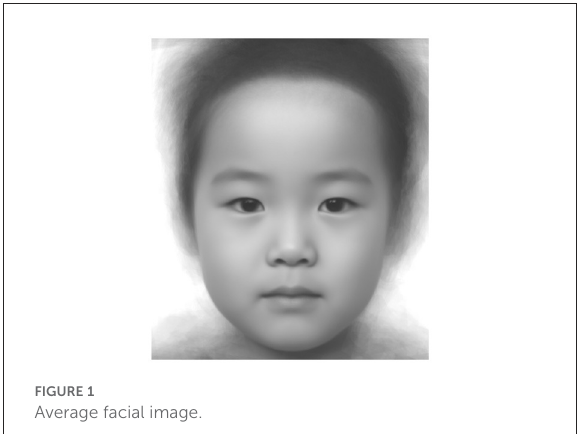
FIGURE1 Average facial image.